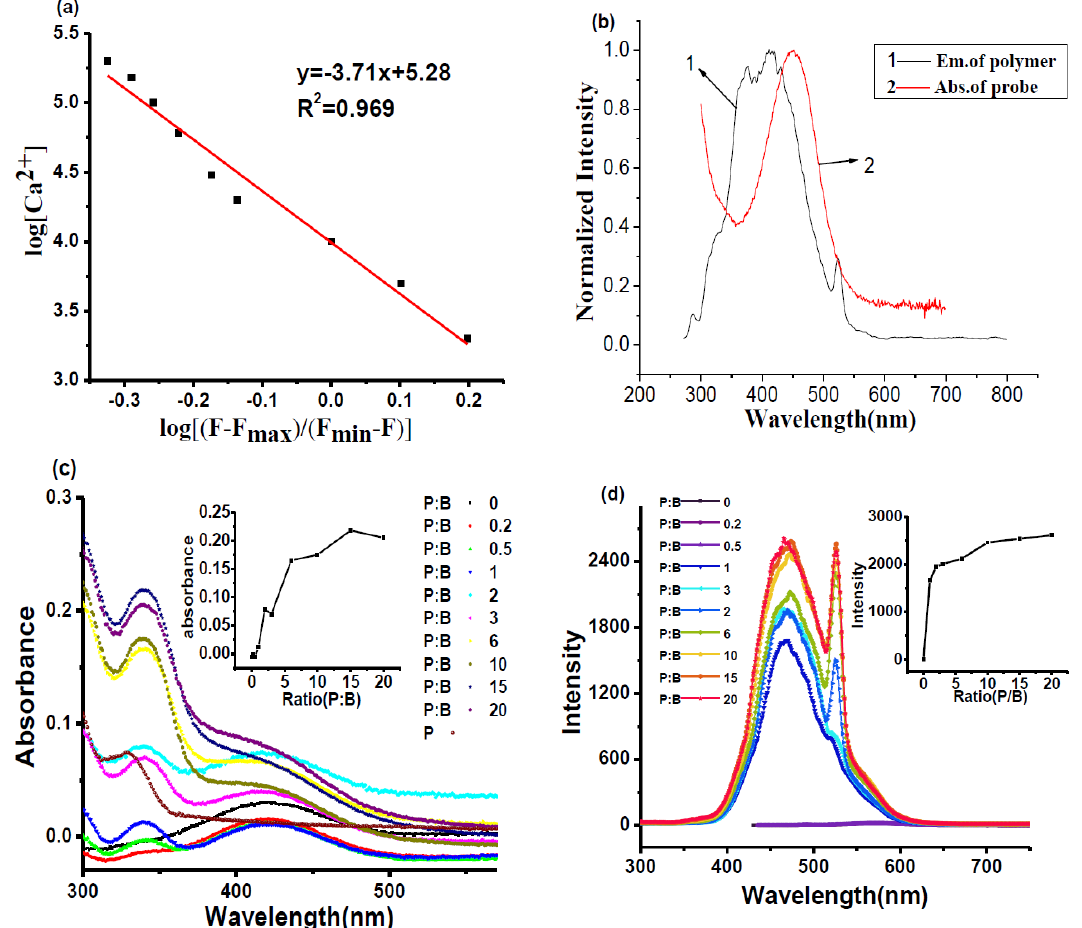
Figure 2. ( a ) Fitting curve of Kd between BAPTAVP and Ca 2+ ; ( b ) normalized spectra for the fluorescence of PCBMB and UV absorption of BAPTAVP; ( c ) UV-vis absorption spectra and ( d ) one-photon fluorescent spectra of BAPTAVP (B) when adding di ff erent volumes of PCBMB(P); inset in upper right corner of ( d ) is the fluorescent changing trend at 465 nm evolution with volumes of PCBMB.